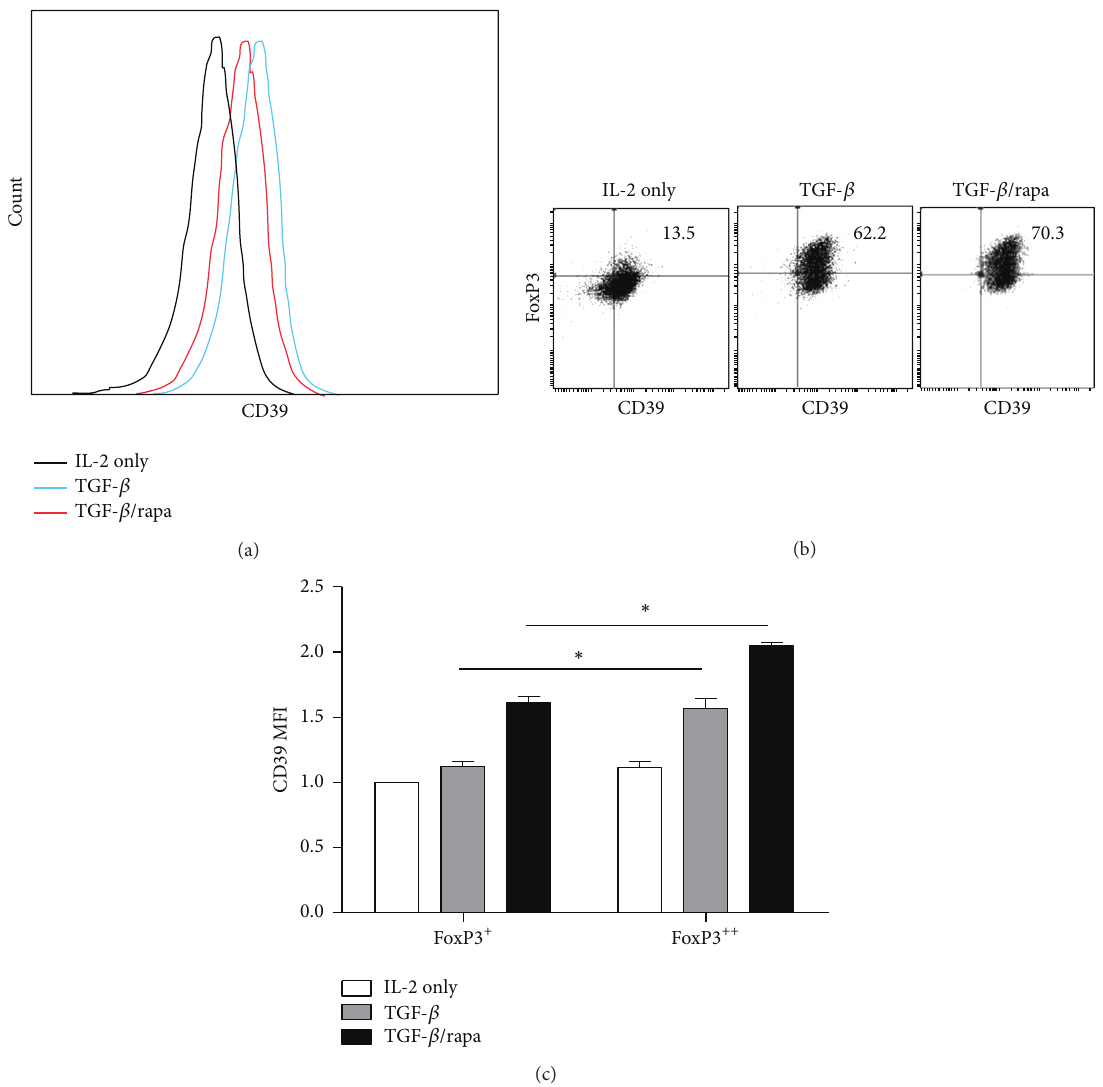
Figure 3: Rapamycin improved CD39 expression in iTreg cells. (a) Representative intensity of CD39 in iTreg cells. (b) FACS analysis of CD39 and FoxP3 expression with or without rapamycin was shown. (c) Relative CD39 MFI in FoxP3 + and FoxP3 ++ iTreg cells on day 7 with or without rapamycin. The values indicated the mean ± SEM of 3 separate experiments. ∗ 𝑃 < 0.05